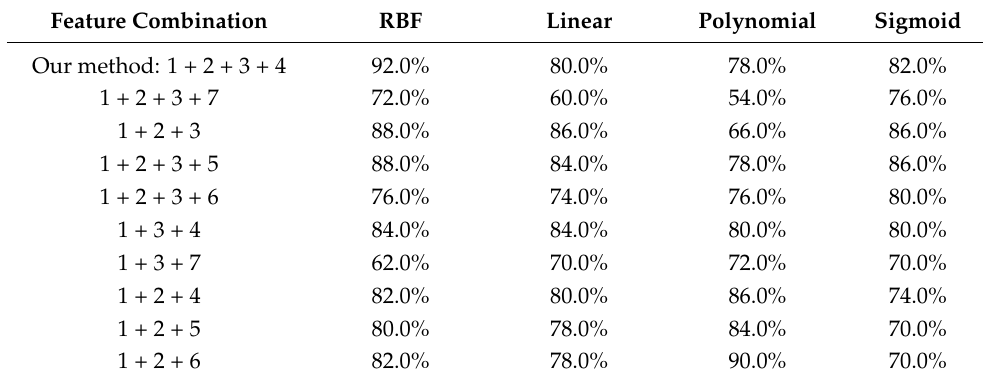
Table 15. The accuracy of IPSO-SVR with different kernel functions. Feature Combination